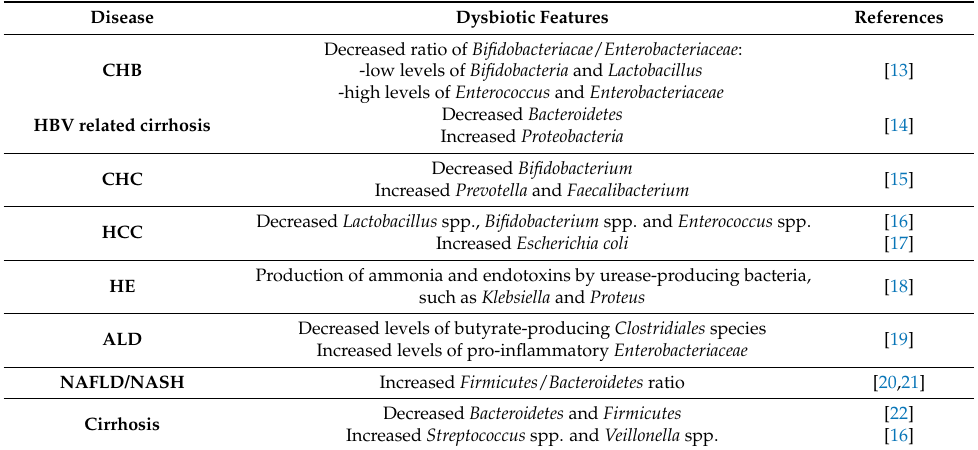
Table 1. Gut microbiota-associated liver